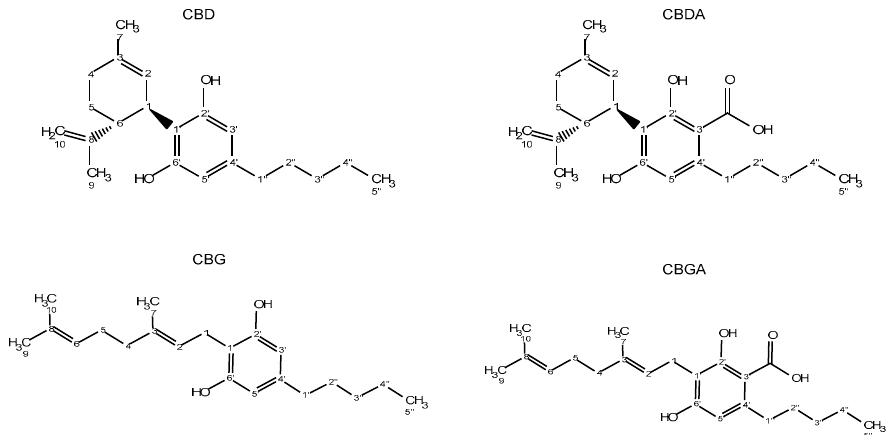
Figure 4. Chemical structures of hemp non-psychoactive cannabinoids. Table 1. 1 H assignments for hemp cannabinoids in CDCl 3.